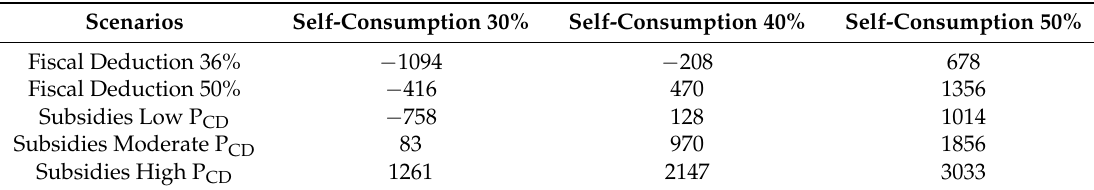
Table 10. NPV in alternative scenario (t r = 1300 kWh/m 2 × year). Data expressed in € .